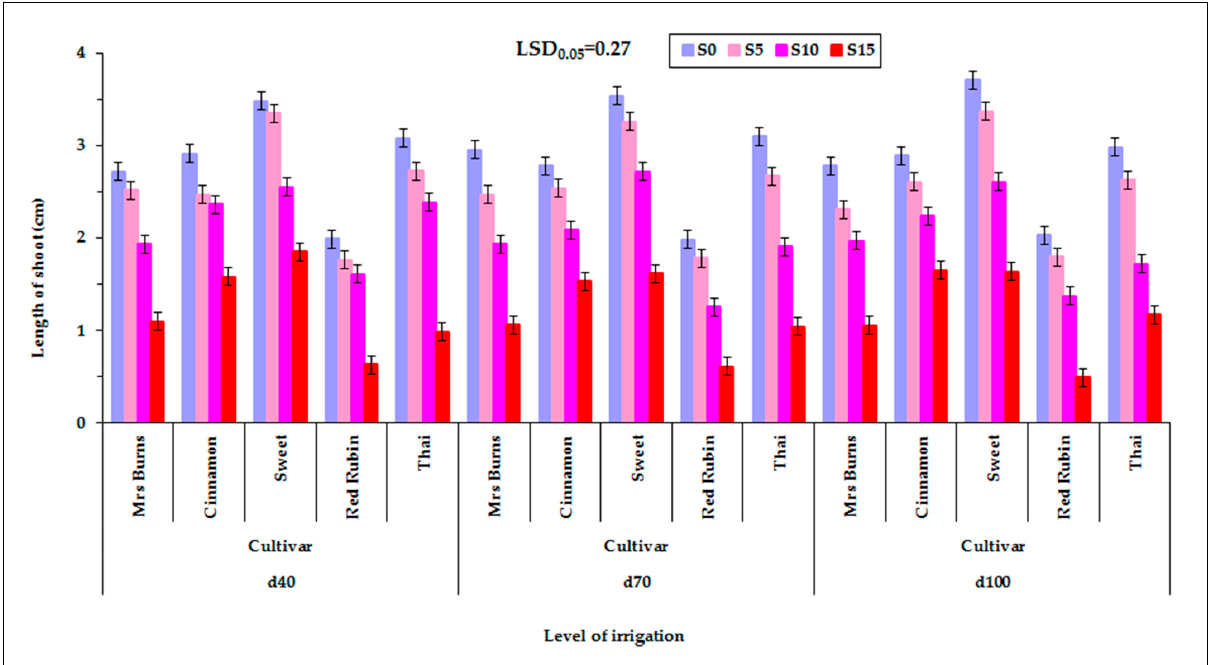
Figure 5. Shoot length of the seedling of the five basil cultivars (“Mrs Burns”, “Cinnamon”, “Sweet”, “Red Rubin” and “Thai”), at the three levels of irrigation (d 40 , d 70 and d 100 ) and at the four PEG concentrations, S 0 for 0% PEG, S 5 for 5% PEG, S 10 for 10% PEG and S 15 for 15% PEG. Data presented are estimated mean values averaged over the two years of experimentation. LSD is the least significant difference at the 0.05 significance level. Error bars correspond to the estimated common standard error of the mean values. Each mean value has been estimated utilizing n = 8 measurements. Figure S5 (see Supplementary Material) presents the observed mean values and the corresponding individual standard errors.